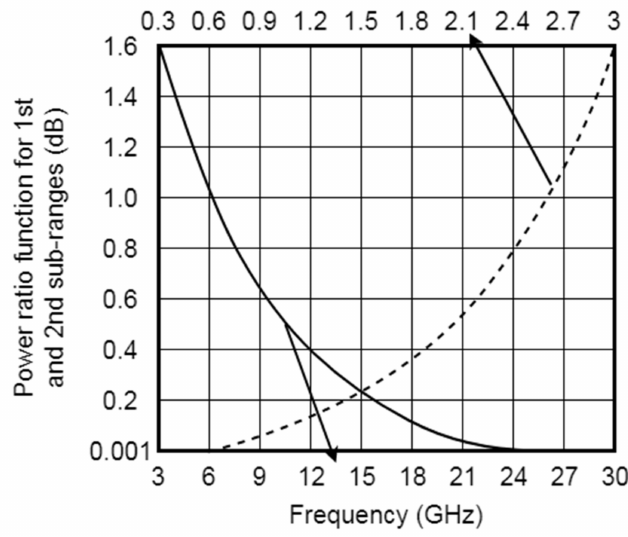
Figure 15. Dependence of ACF on f RF (adapted from